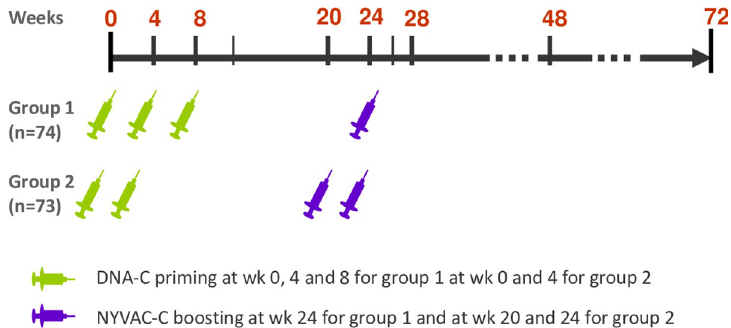
Fig 7. Trial design, EV03/ANRS VAC20 Phase I/II Trial. Schematic representation of EV03 study design: three injections of DNA (at weeks 0, 4 and 8) plus one NYVAC (at week 24) or two DNA (weeks 0, 4) plus two NYVAC (weeks 20, 24) were administered in 3xDNA and 2xDNA groups,